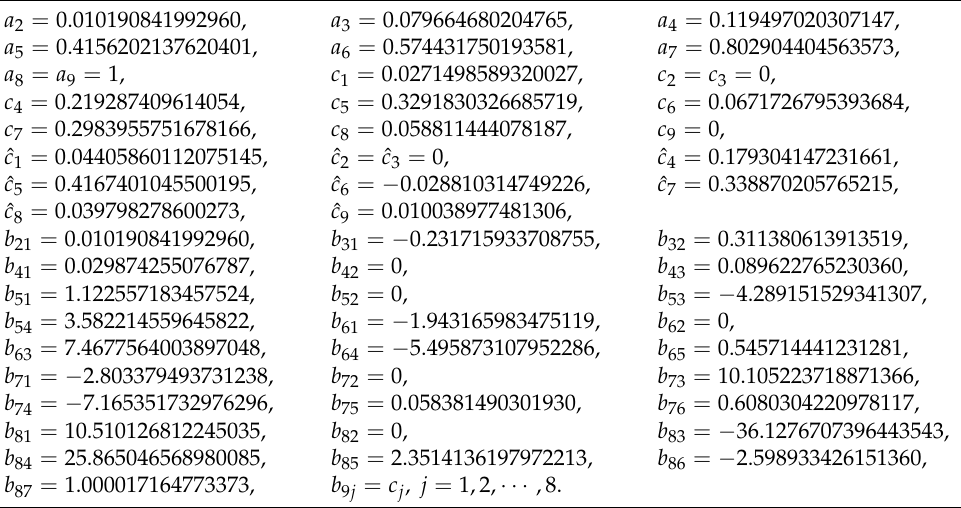
Table 1. Coefficients of the here-proposed NEW6(5) pair, accurate for double precision computations. a 2 =